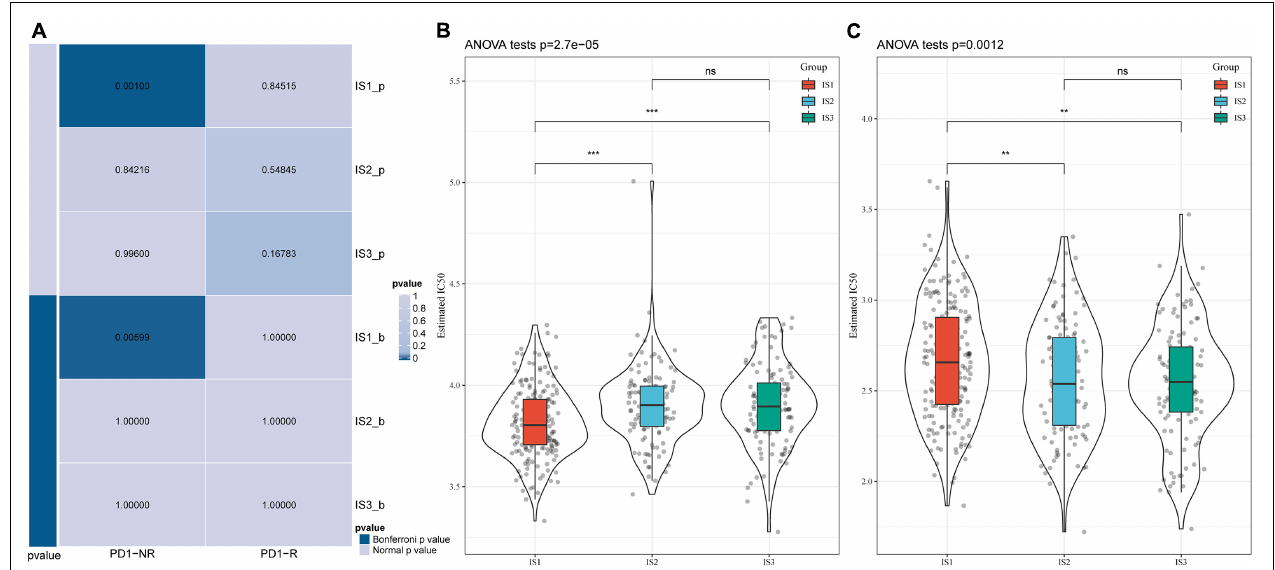
FIGURE 6 | Differential analysis of immune subtypes on immunotherapy/chemotherapy. (A) Results of the submap analysis showed that IS1 was not sensitive to the programmed cell death protein 1 inhibitor (Bonferroni-corrected P < 0.05). The box plots of the estimated IC50 for (B) 5-Fluorouracil and (C) Cisplatin. ** P < 0.01, *** P <